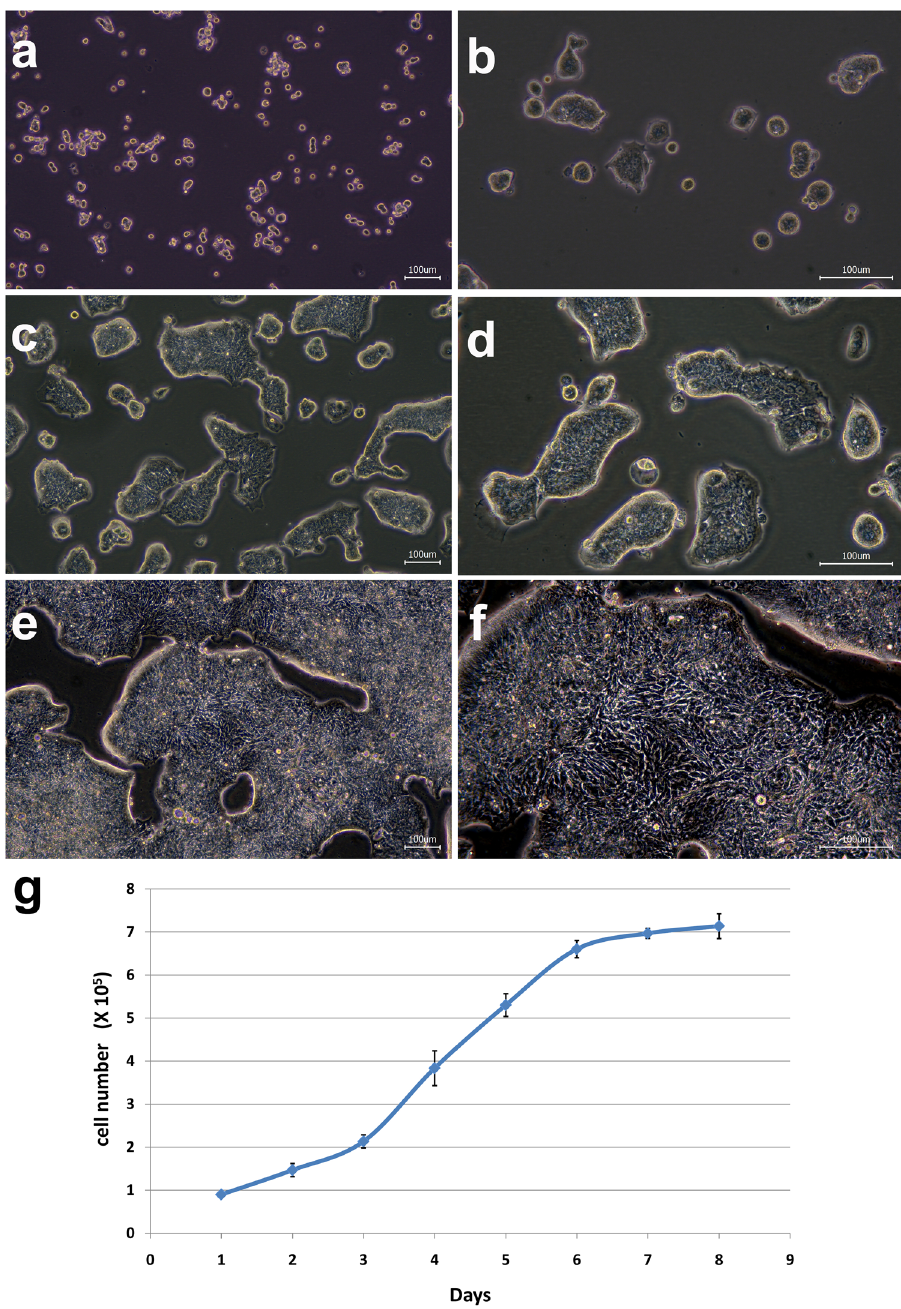
Figure 1. Growth characteristics of the PUMC-CRC1 cells. ( a , b ) Morphological images of PUMC-CRC1 at low density under low and high magnification respectively. ( c , d ) Morphological images of PUMC-CRC1 at medium density under low and high magnification respectively. ( e , f ) Morphological images of PUMC-CRC1 at high density under low and high magnification respectively. ( c ) Growth curve of PUMC-CRC1 cells at P22 using cell